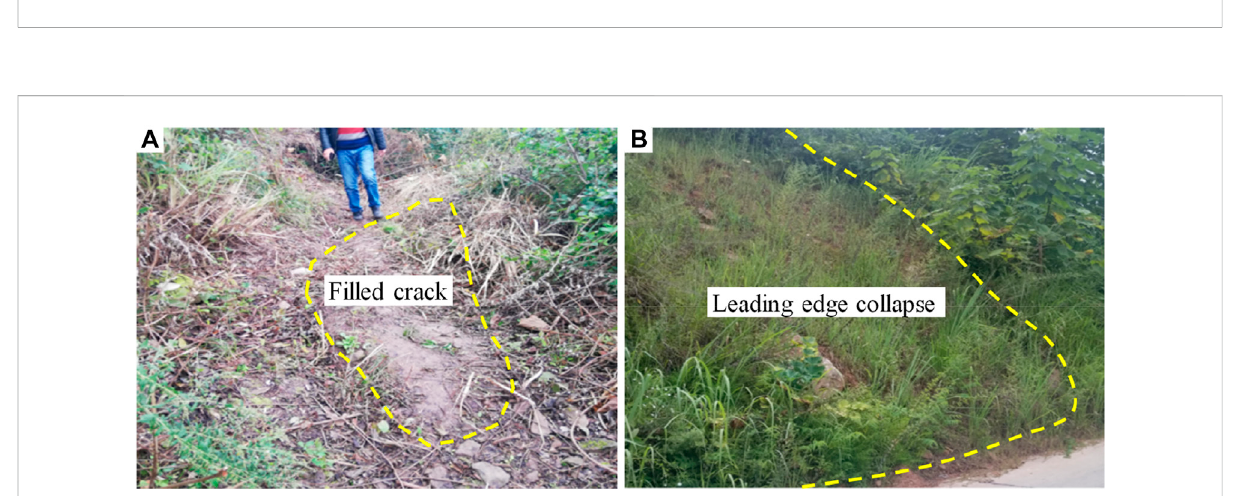
Landslide boundary. (A) The rear edge of the landslide. (B) The front edge of the landslide. (C) The left boundary of the landslide. (D) The right boundary of the landslide.